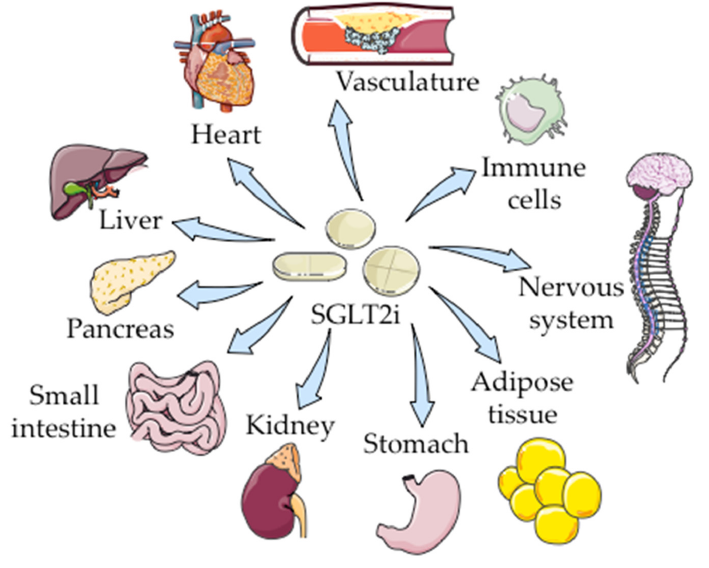
Figure 2. Main therapeutic targets of SGLT2i. The figure was drawn using pictures from